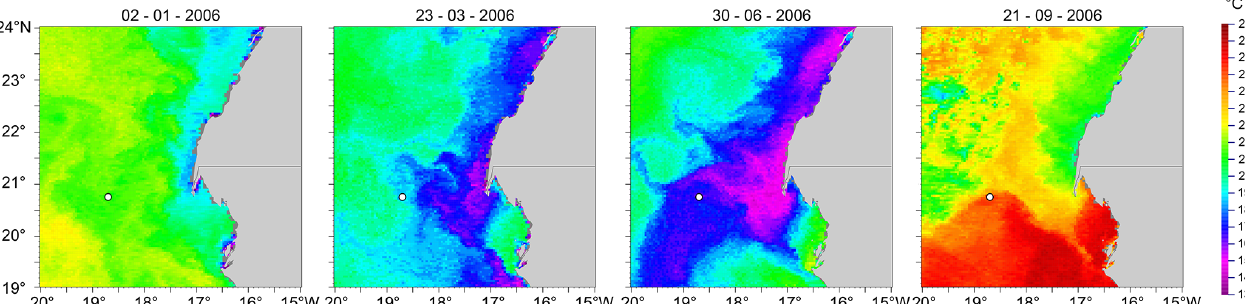
Figure 2. Temperature distribution off Cap Blanc for 4d, each from a different season. The location of sediment trap CBeu is indicated by a white circle. Colder waters near the African coast result from upwelling. The westward extension and location of colder upwelled waters is highly variable as is upwelling. Days with strong (30 June 2006) or weak (2 January 2006) upwelling may occur any time of the year. From mid-July to November a temperature pattern similar to that of 21 September 2006 is more typical. Data are from ERDDAP, ID: nceiPH53sstn1day_Lon0360. NOAA Climate Data Record, AVHRR Pathfinder Version 5.3 L3-Collated. Data are courtesy of